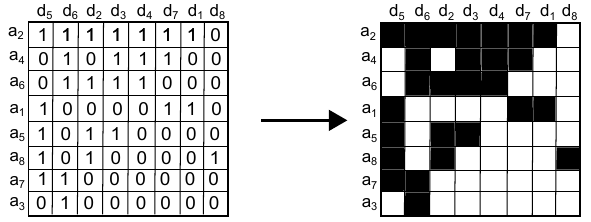
Figure 2. Step 2. Example of mapping a sorted Q w matrix into an image.